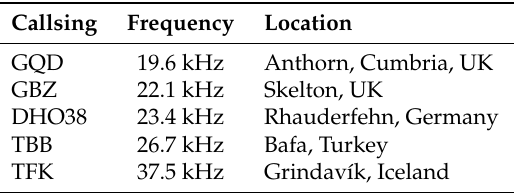
Table 1. VLF transmitters used in the